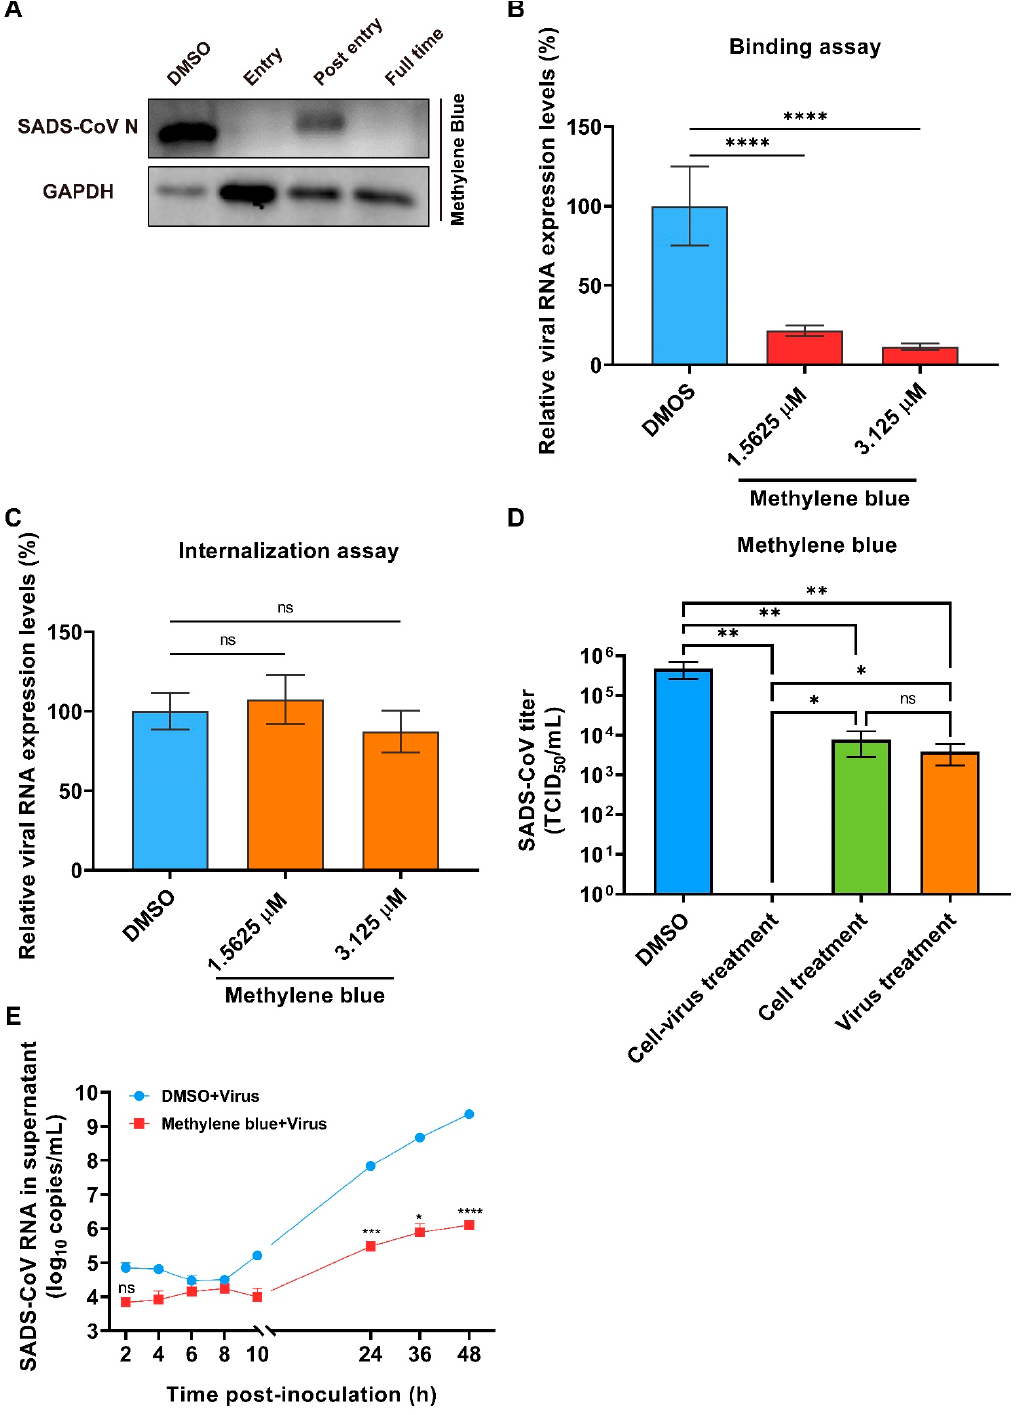
Figure 6. Methylene blue inhibits SADS-CoV infection. The proteins in the cells were collected from the time-of-addition assay and were tested for the expressions of viral proteins ( A ). The inhibitory effect of methylene blue on SADS-CoV binding ( B ) and internalization ( C ) were evaluated. SADS-CoV titer was tested by TCID 50 after 24 hpi when different methylene blue treatments were used before infection ( D ). The growth kinetics of SADS-CoV in the presence of methylene blue (1.5625 µ M) was also examined ( E ). DMSO was added as the positive control. The experiments were repeated at least twice. Error bars represent ± 1 SD; ns, no significant difference; * p < 0.05, ** p < 0.01, *** p < 0.001, **** p < 0.0001 by Student’s t